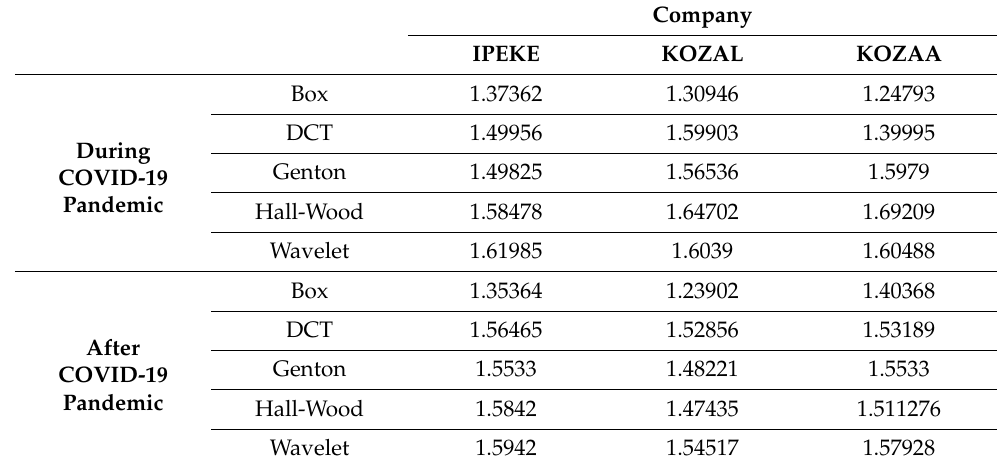
Table A9. Fractal dimensions for the mining sector.